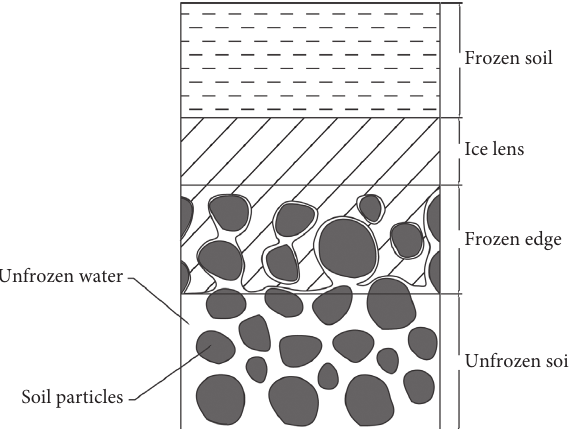
Figure 1: Frozen section model (second frost heave